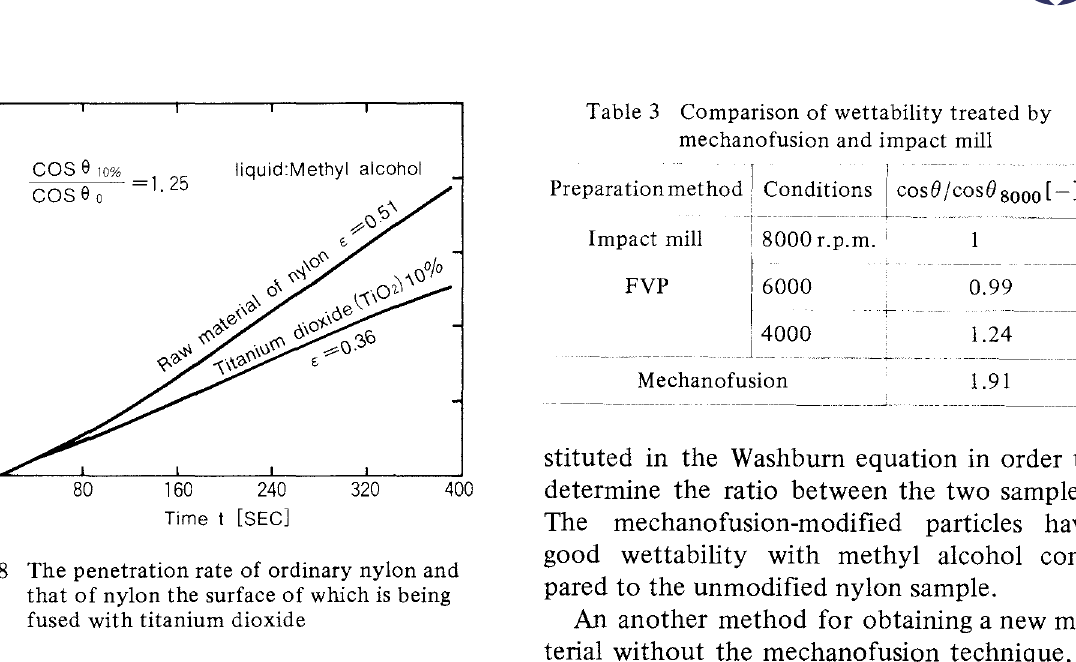
Fig. 18 The penetration rate of ordinary nylon and that of nylon the surface of which is being fused with titanium dioxide